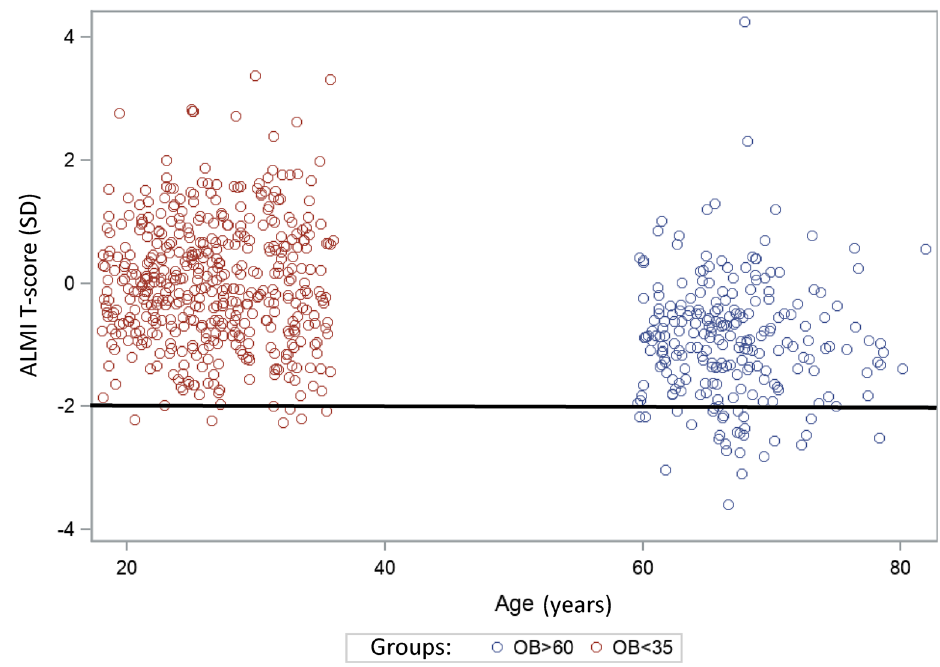
Figure 5. ALMI T-score determined in young and older women with obesity. ALMI: appendicular lean mass index (sum of the lean soft tissue mass for the arms and legs)/height 2 ; SD: standard deviation. T-score was calculated as follows: [(ALMi measured) − (ALMI predict)]/(standard deviation) with ALMI predict = 2.07996 + 0.1828*BMI and SD = 0.7180668. Patients were considered sarcopenic when ALMI T-score < −